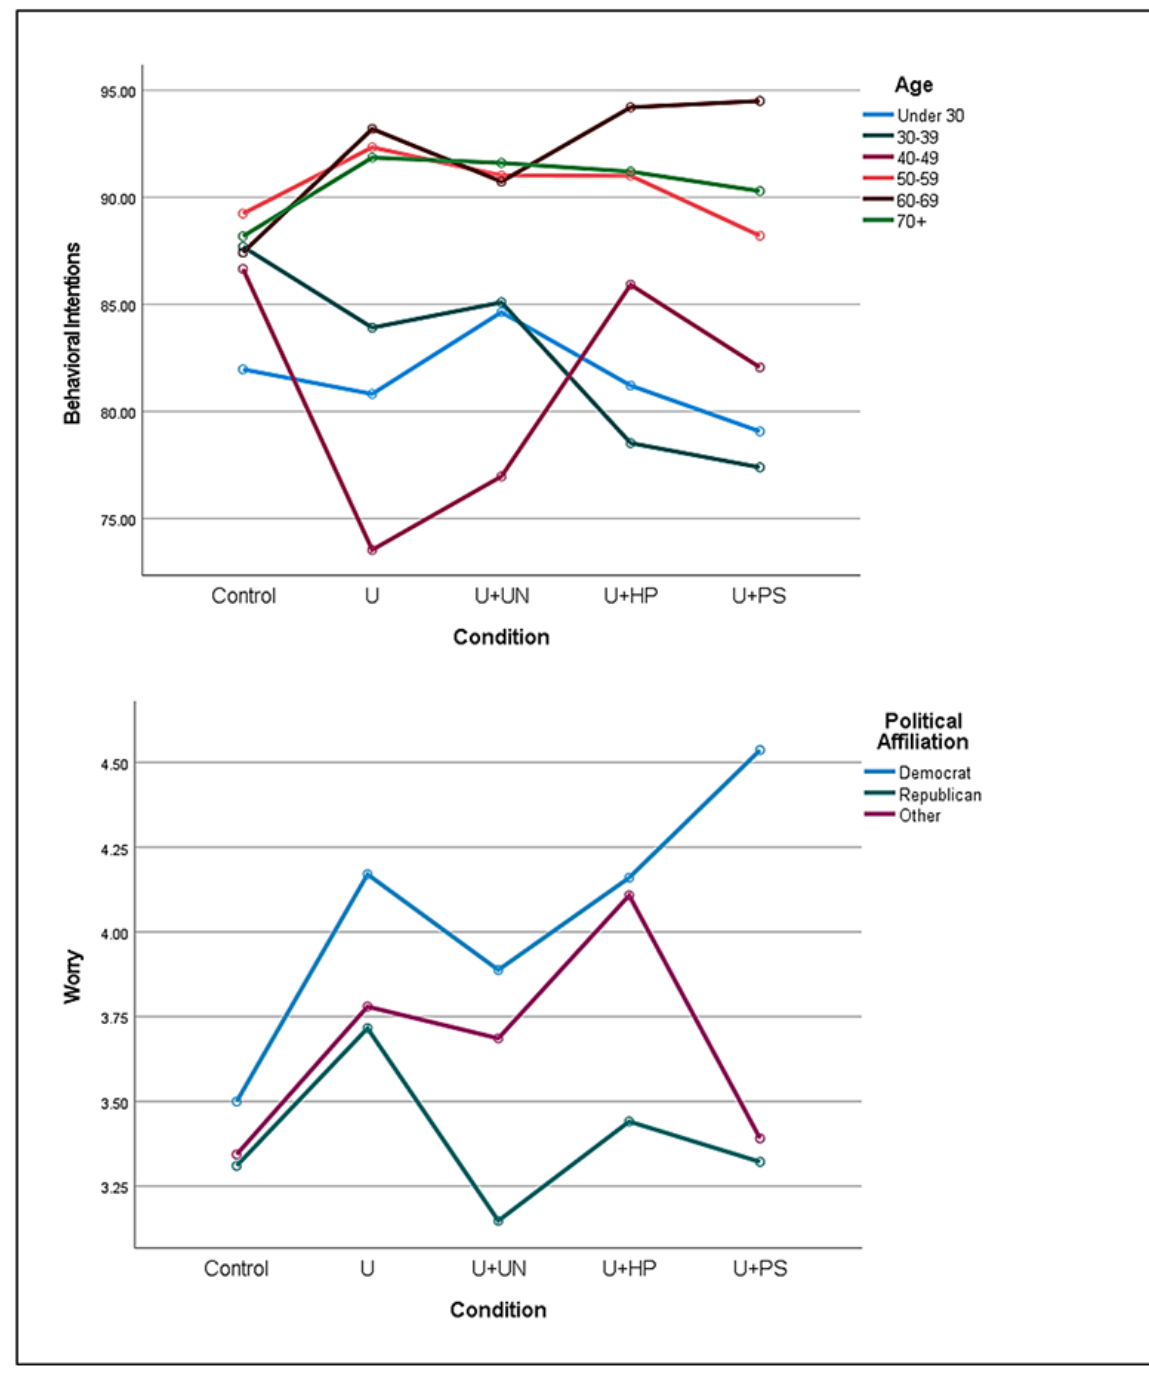
Figure 3. Moderators of the effects of uncertainty communication strategy on manifestations of ambiguity aversion: age and political affiliation.